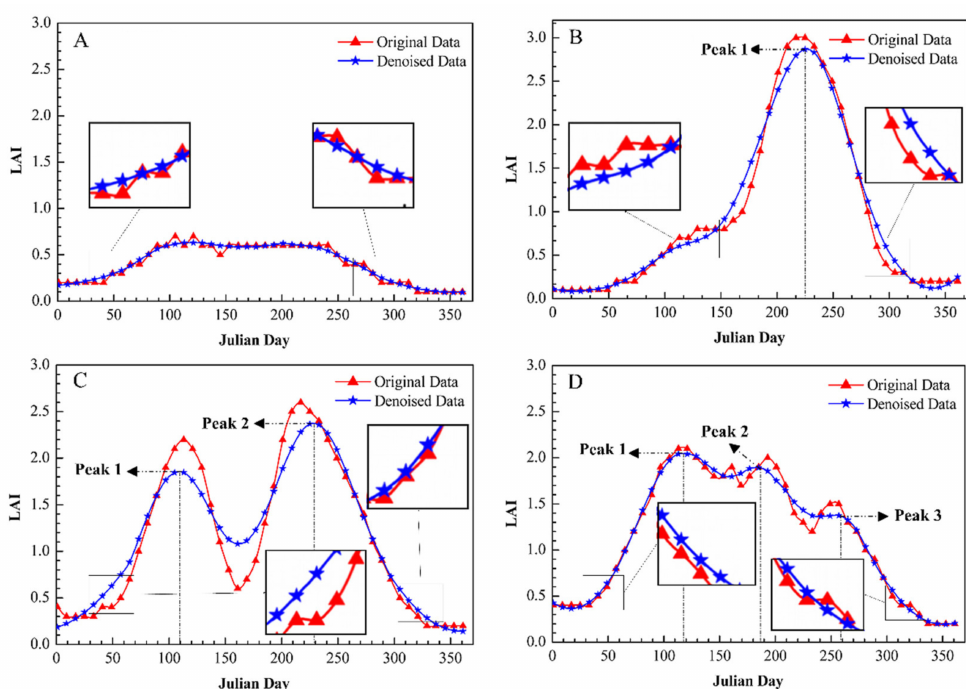
Figure 3. Smoothness of LAI time series for different cropping systems. ( A ) No-peak curve in fallow field; ( B ) unimodal curve in single cropping; ( C ) bimodal curve in double cropping; ( D ) three-peak curve in triple